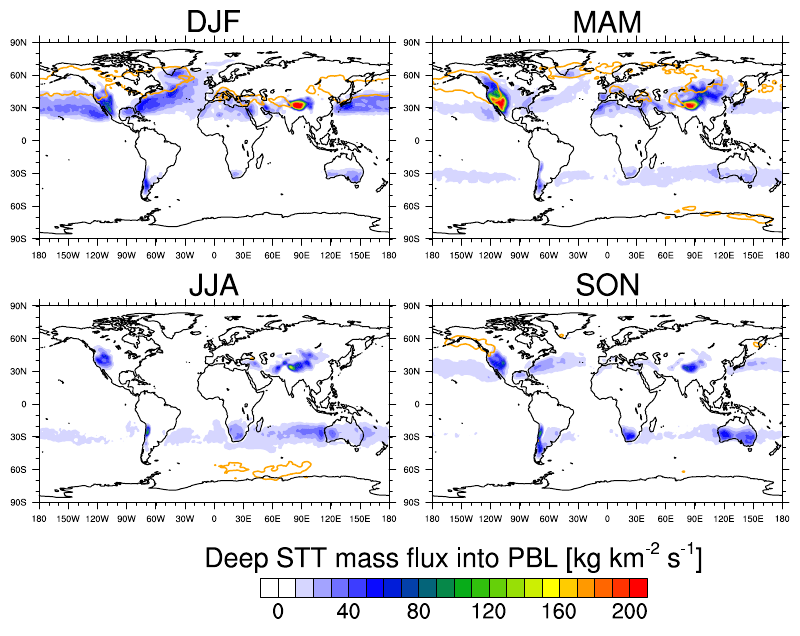
Fig. 5. Seasonally averaged deep STT mass flux into the PBL for 1979–2011. The orange contours indicate areas where the mass flux across the tropopause due to deep STT is higher than 25kgkm − 2 s − 1